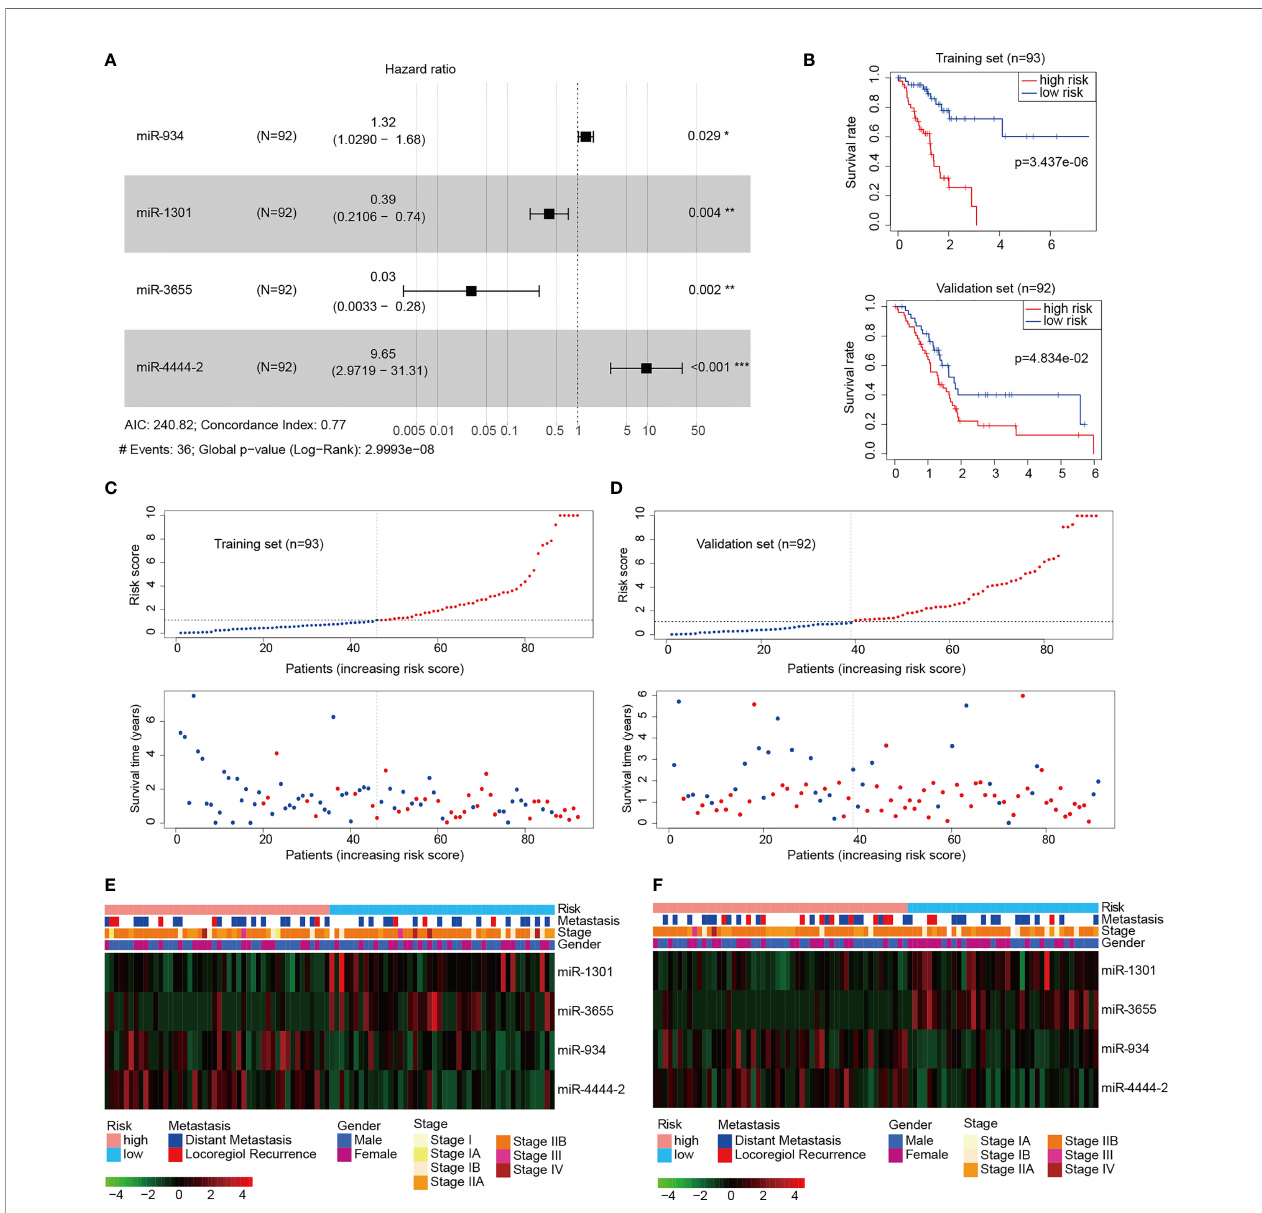
FIGURE 2 | Construction of the pancreatic adenocarcinomas (PAAD) prognostic signature. (A) Forest plot of the 4-miRNA panel (miR-1301, miR-3655, miR-934, and miR-4444-2) multivariate Cox regression analysis in the validation cohort (n=92) from TCGA PAAD (Wald test, *P < 0.05, **P < 0.01, ***P < 0.001). (B) Kaplan- Meier curves of overall survival based on the high and low risk group in the training (n=93, top) and validation cohort (n=92, bottom) compared statistically using the log rank test. (C, D) Risk score distribution, survival status of each patient in the training cohort (C) and validation cohort (D) . (E, F) The heatmap plots of the 4- miRNA panel with characteristics including prognostic signature risk subgroup and clinical pathology in the training cohort (E) and validation cohort (F)